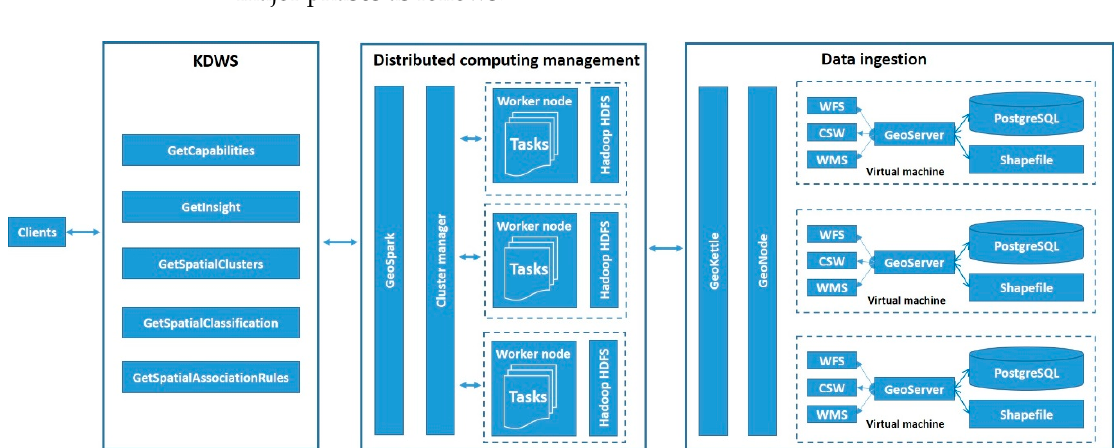
Figure 10. The implementation workflow of the proposed solution.